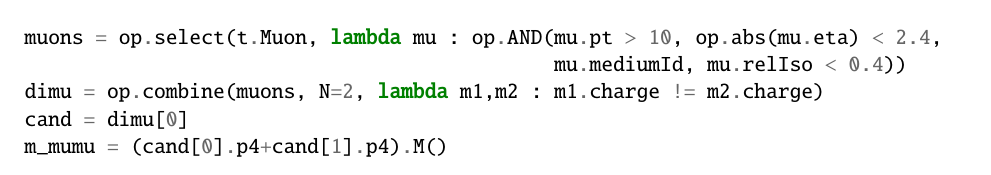
Figure 1. Example bamboo code to select reconstructed muons that pass some selection criteria, con- struct a list of dimuon candidates with opposite charge, and calculate the mass of the first candidate.